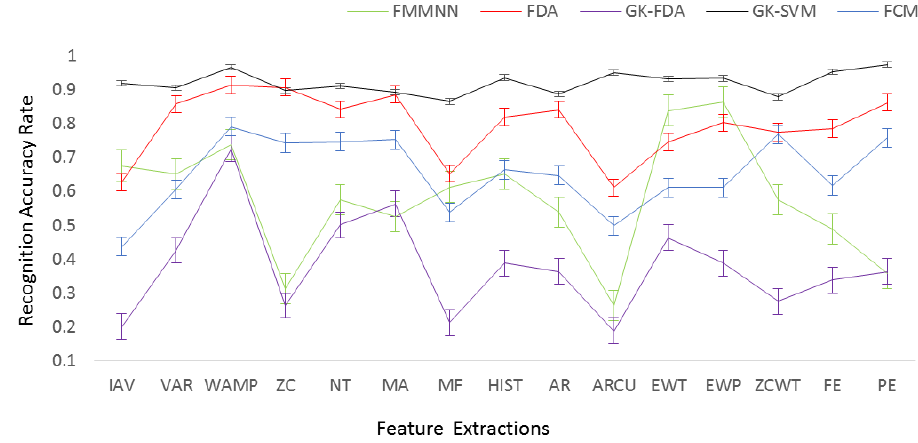
Figure 7. Average of Recognition Accuracy Rates (error bar: standard error).